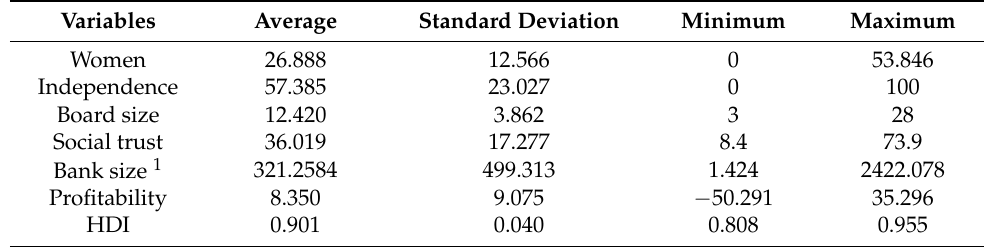
Table 2. Descriptive statistics of the independent and continuous control variables.